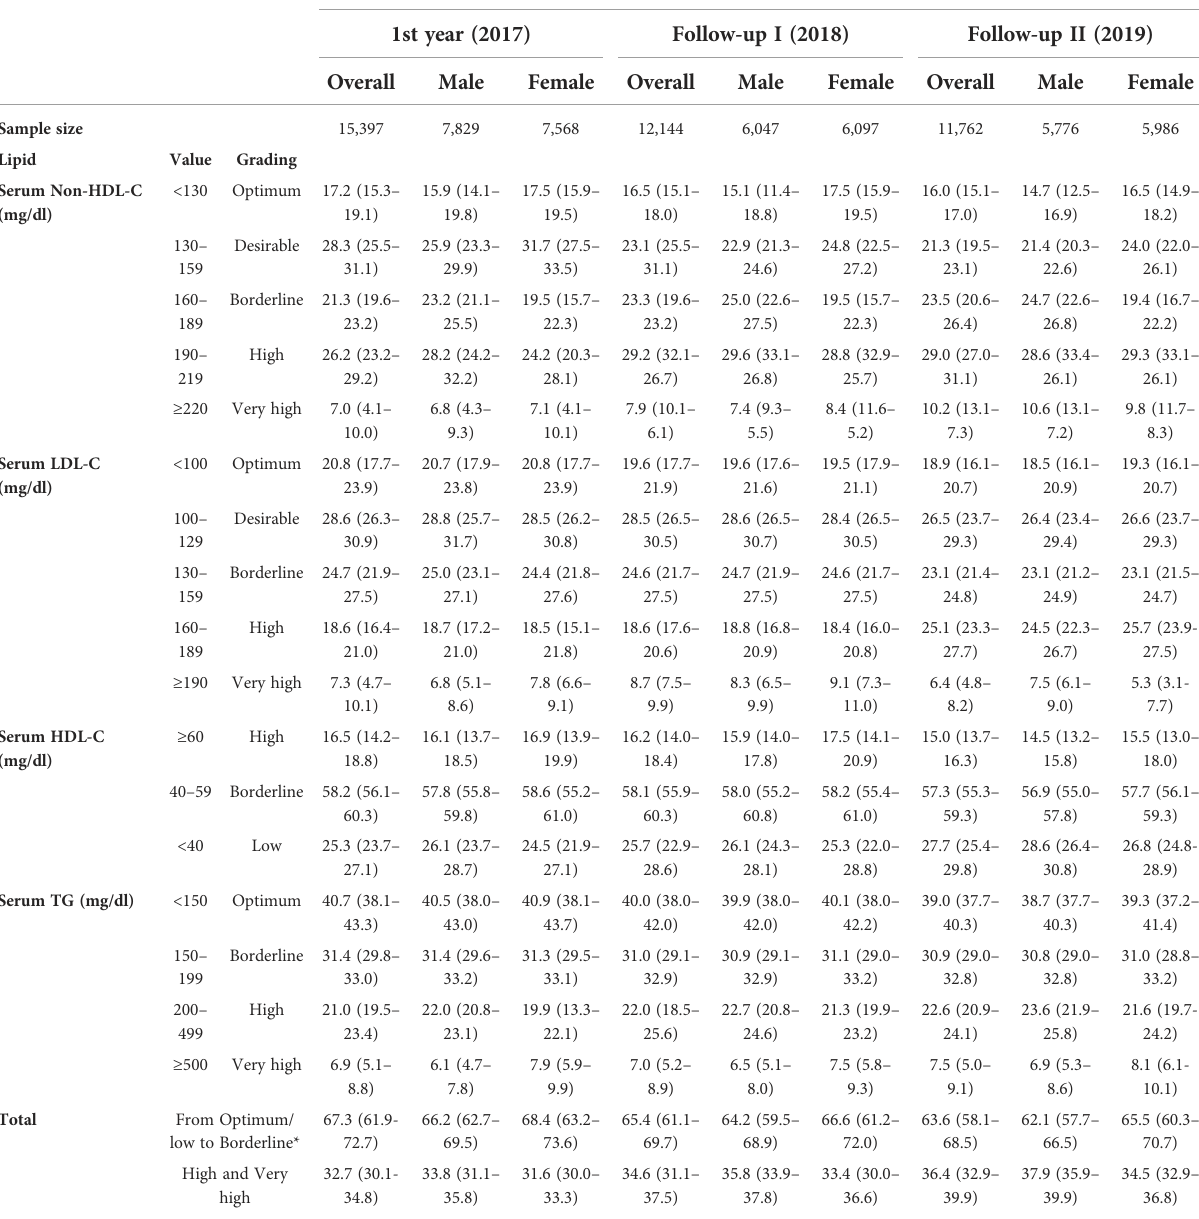
TABLE 3 Distribution of lipid abnormalities among adults in East Coast, Fujian, China in 2017 and 2-year